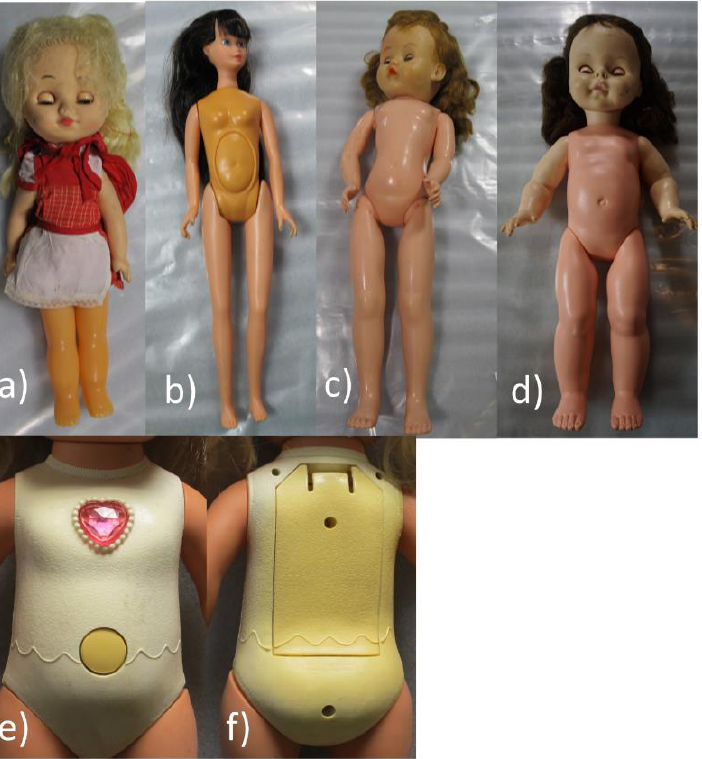
Figure 6. Dolls showing discolouration. ( a ) Doll G8 constructed with PE torso, legs and PVC arms and head. The legs have become discoloured and yellowed with age. ( b ) Doll I8, featured a discoloured PS torso ( c ) doll E6 with CA body, arms and legs and a discoloured PVC head. ( d ) Doll H7 with PE legs and torso, discoloured PVC arms and legs ( e ) Doll B4 with PS front (less yellow) ( f ) Doll B4 with PS back (more yellowed). Image © Tate.